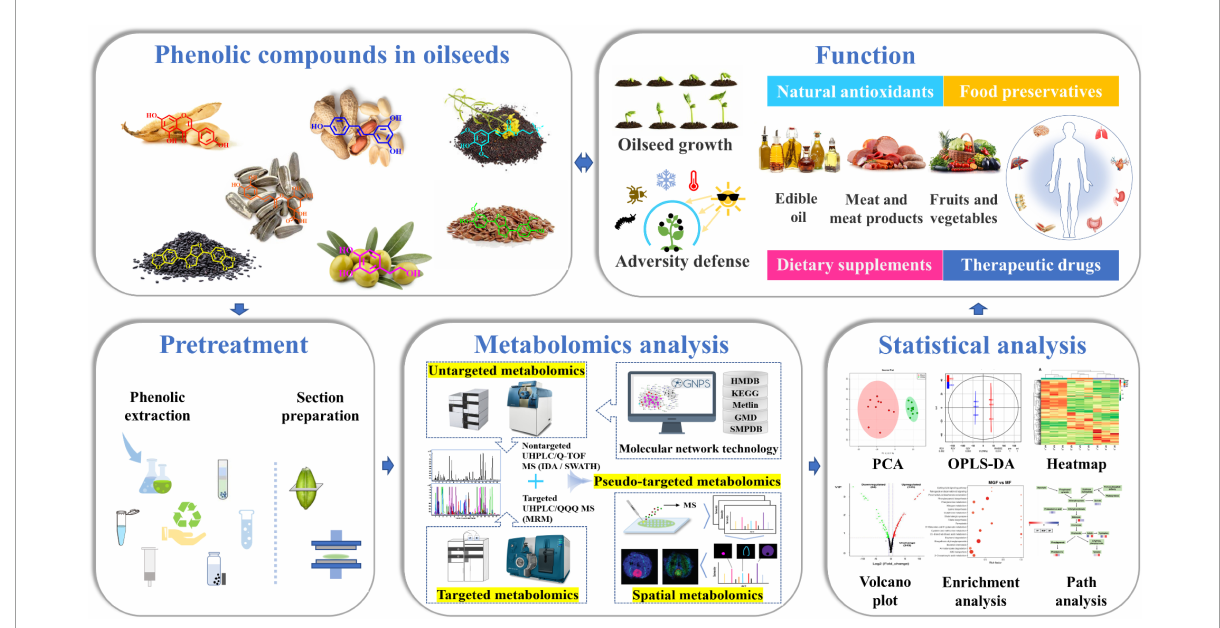
FIGURE2 Flow chart of phenolic compound analysis. Phenolic compounds in oilseeds play an important role in oilseed growth and adversity defense. The profiling of phenolic compounds includes pretreatment, metabolomics analysis and statistical analysis. Pretreatment includes phenolic compounds extraction and section preparation. Metabolomics analysis can be further divided as untargeted, targeted, pseudo-targeted and spatial metabolomics. Statistical analysis commonly includes PCA, OPLS-DA, Heatmap analysis, Volcano plot analysis, enrichment analysis, and path analysis. The analysis results can provide reliable data support for the applications of phenolic compounds in foods, health care products and